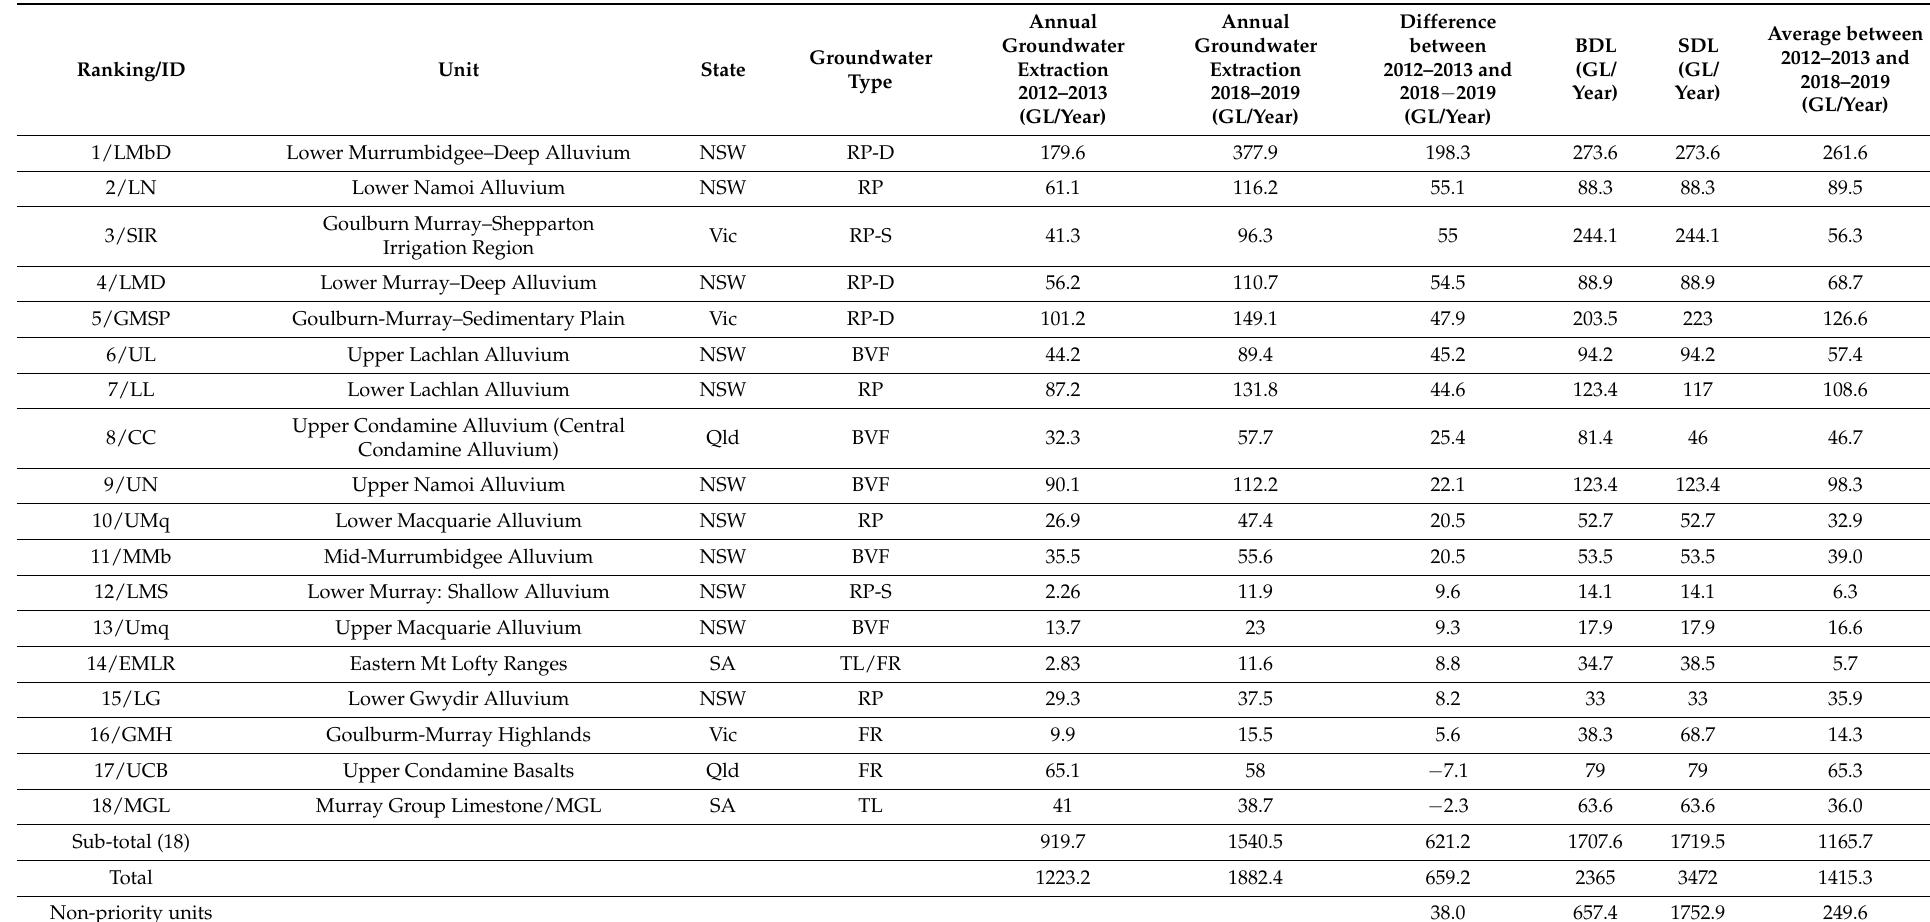
Table 1. The fifteen groundwater SDL units with the largest difference between extraction volume during the 2012–2013 and 2018–2019 years and an additional three units with large variations during this time. Additionally shown is the state in which the unit is found, their groundwater type, the extraction volumes in 2012–2013 and 2018–2019 in GL, the difference between these, the BDL and SDL in GL/year, and the average annual extraction volume over the period. The alluvial groundwater types are denoted by RP (Riverine Plain), RP-D (deeper units of the Riverine Plain), RP-S (shallow unit of Riverine Plain, BVF (broad-valley-constrained floodplain), and NVF (narrow-valley-constrained floodplain). FR denotes a fractured rock